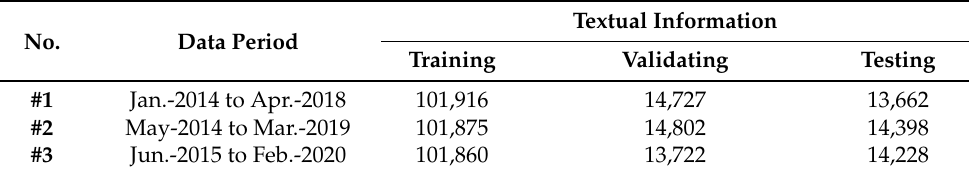
Table 4. Textual data summary showing the number of total news headlines; there are many news headlines per